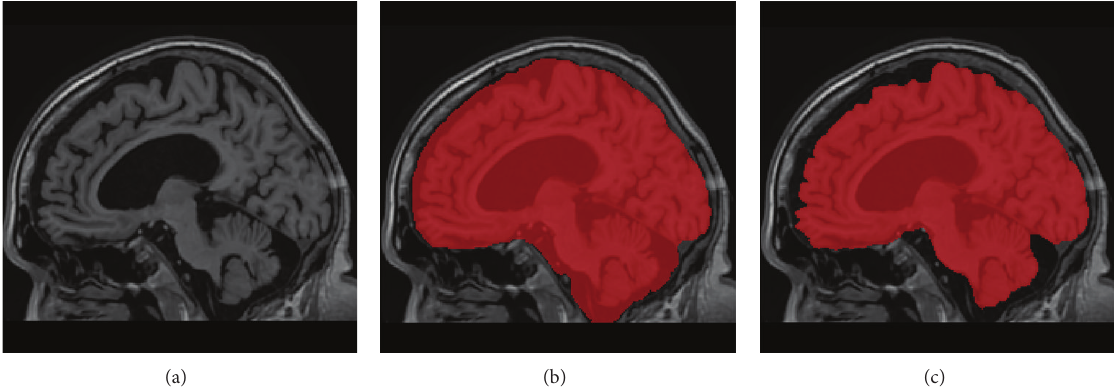
Figure 2: Example of mask differences between our mask definition (b) and BEaST mask (c) for an Alzheimer’s case (a). As can be noticed, all external CSF is included in NICE mask while this is not case at the corresponding BEaST mask (example case from Oasis dataset).